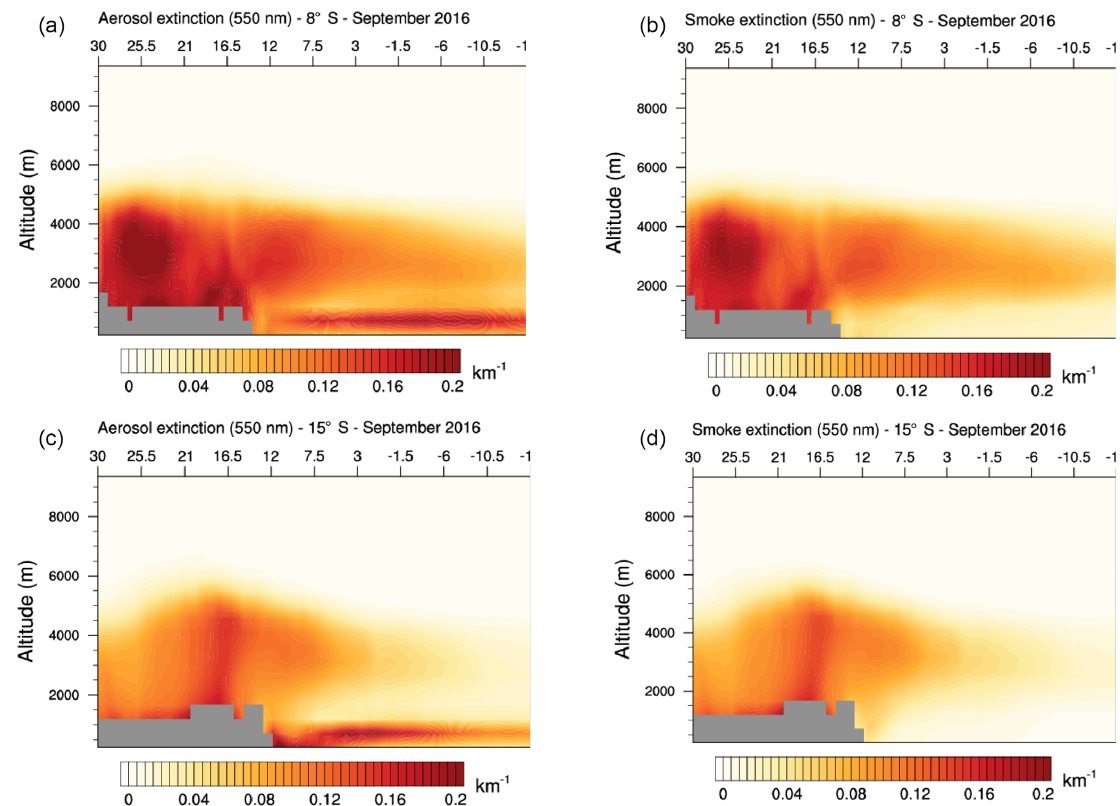
Figure 7. Monthly averaged vertical profiles of the total aerosol (a) and smoke (b) extinction coefficient (at 550nm) simulated by the ALADIN-Climate model for two transects at latitudes of 8 and 15 ◦ S. Longitudes are between 30 ◦ E and 11.5 ◦